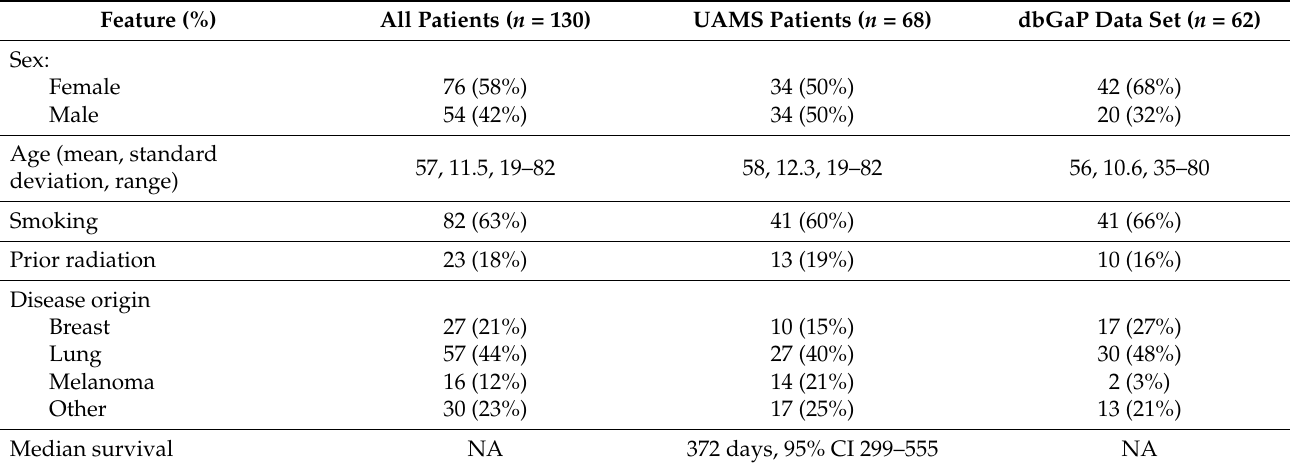
Table 1. Patient characteristics. The UAMS and dbGaP data sets were of similar sizes and compositions. Feature (%) All Patients ( n =